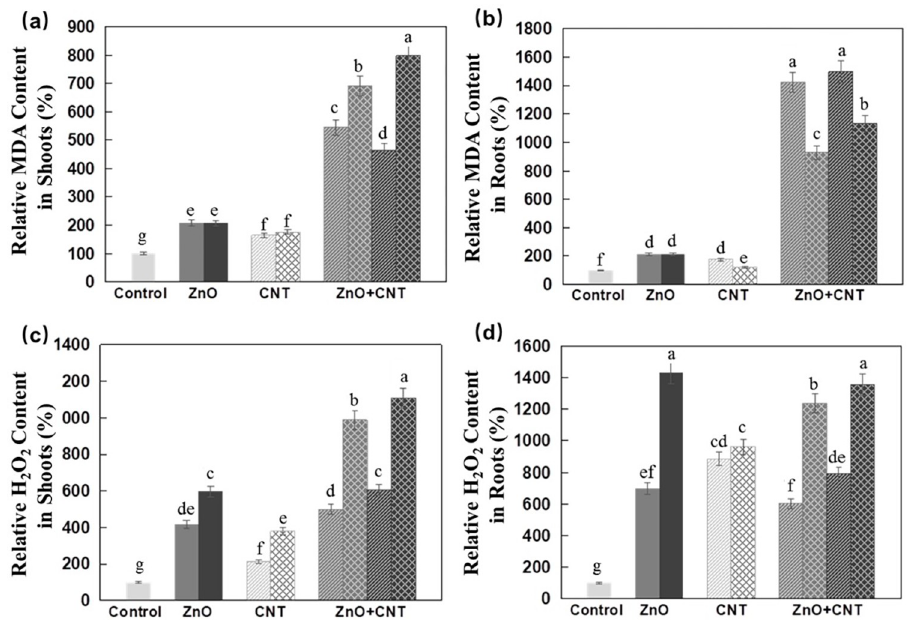
Fig 3. Effects of ZnO NPs and MWCNTs, alone or in combination, on MDA and H 2 O 2 content of Arabidopsis seedlings at 10 DAG. (a) Relative MDA content in shoots. (b) Relative MDA content in roots. (c) Relative H 2 O 2 content in shoots. (d) Relative H 2 O 2 content in roots. ½ MS medium without NPs was used as control. Data are the means ± standard errors of three replicates. Different letters indicate a significant difference between treatments ( P < 0.05, Duncan